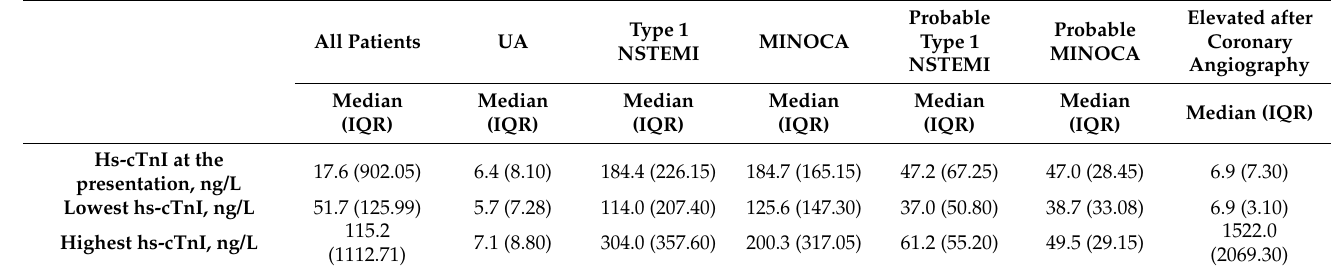
Table 2. Median values of high sensitivity cardiac troponin-I after